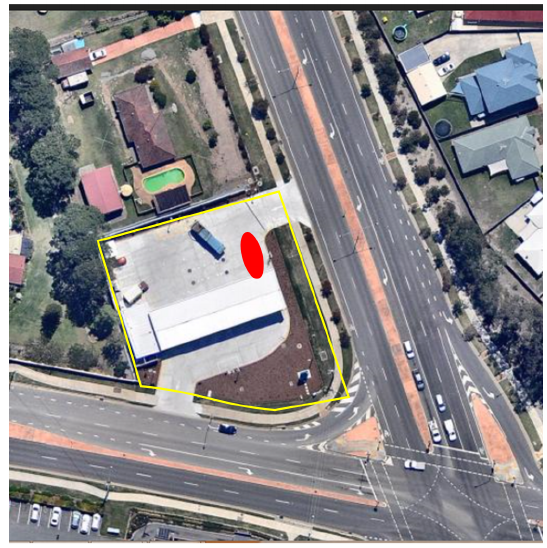
Figure 5. Aerial photograph of the Warner refueling site with approximate property boundary shown by yellow line.